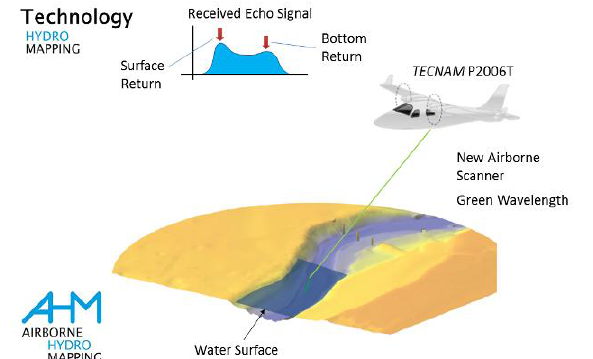
Figure 1: Principal representation of the penetration and deviation of the laser impulse on and in the water. The runtime difference between water surface and sole allows determination of the waters’